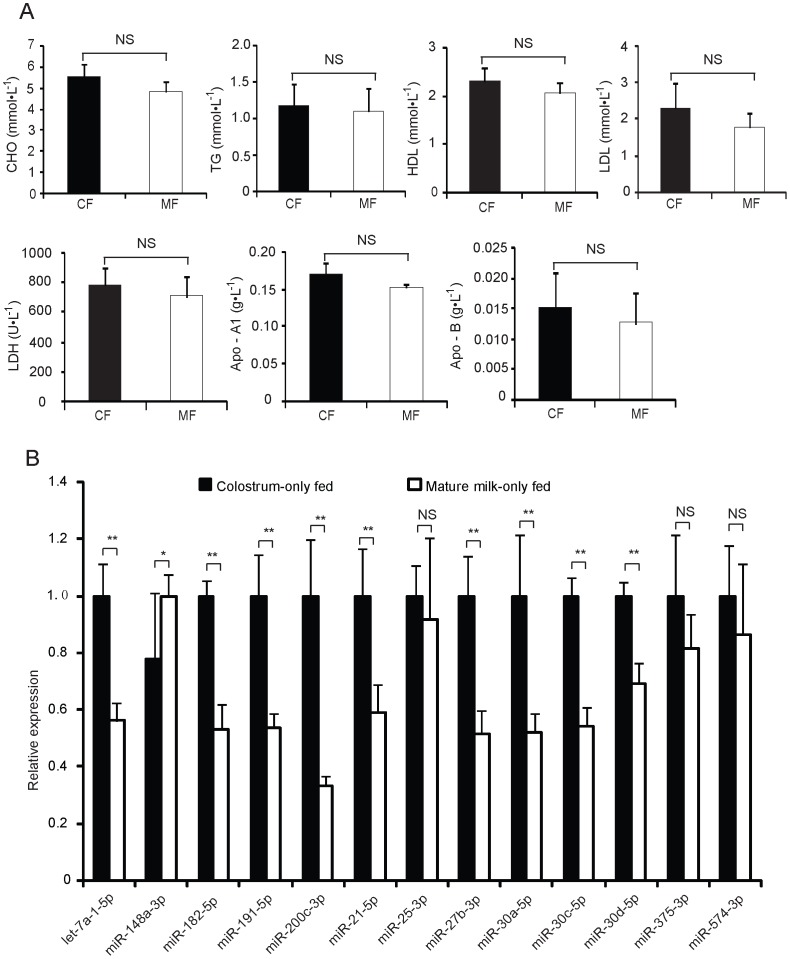
Differences of circulating metabolic indicators and immune-related miRNAs in serum between the colostrum-only and the mature milk-only fed piglets.(A) Seven representative circulating indicators of metabolism. (B) Thirteen well-characterized immune-related miRNAs. The data are normally distributed (Kolmogorov-Smirnov test, p>0.05). The statistical significance was calculated by Student’s t-test (n = 6 per group). Values are means±SD. CF: colostrum-only feeding; MF: mature milk-only feeding.